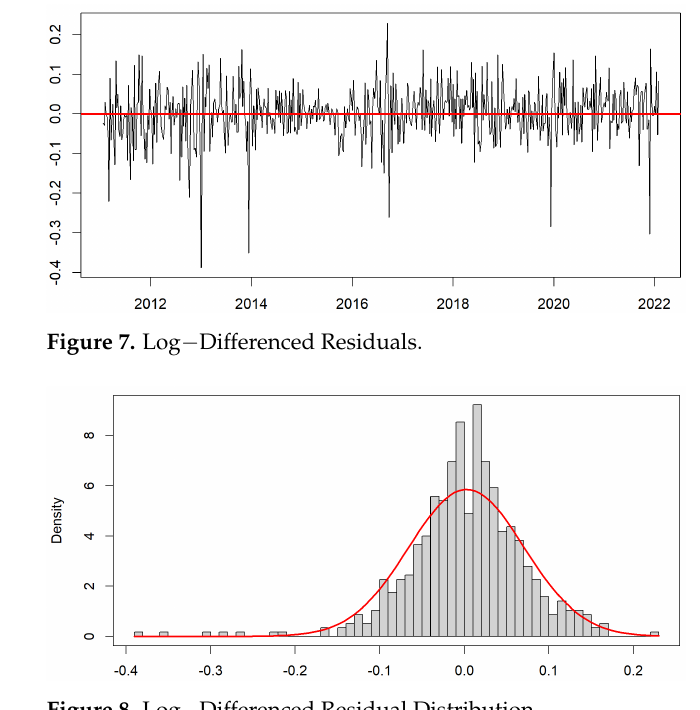
Figure 8. Log − Differenced Residual Distribution.